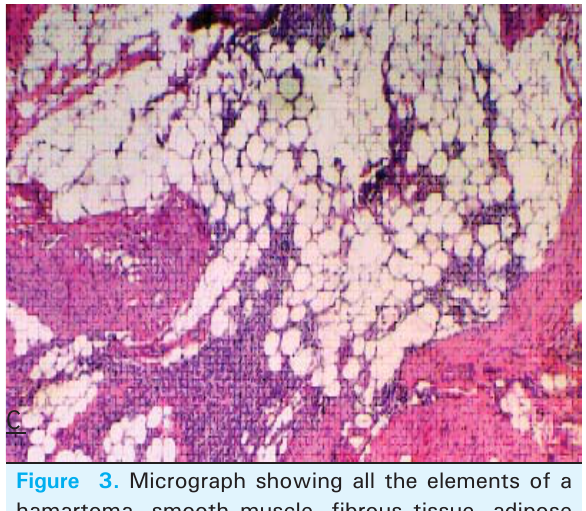
Figure 3. Micrograph showing all the elements of a hamartoma- smooth muscle, fi brous tissue, adipose tissue and blood vessels with a disorganized growth pattern (HE stain, X400) The case was diagnosed as retroperitoneal